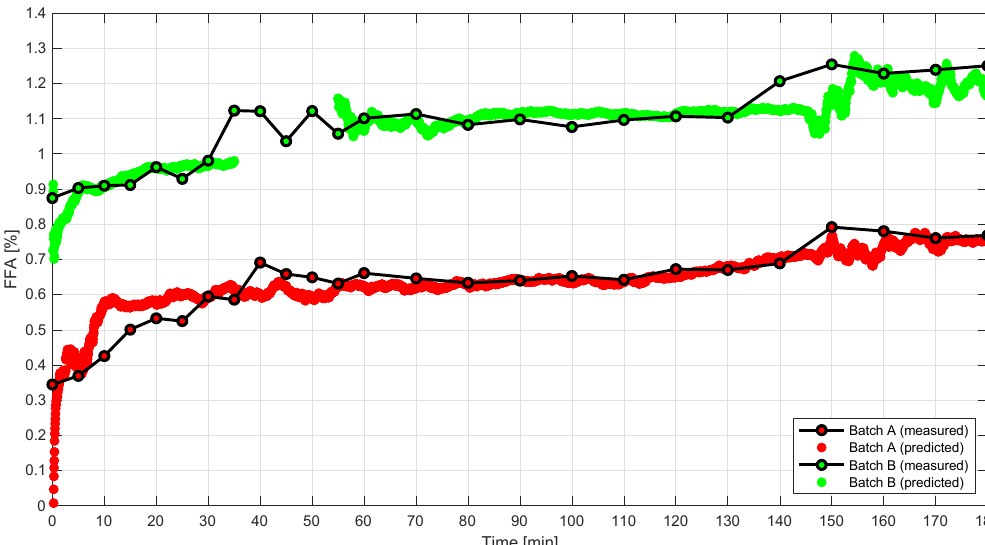
Figure 9. Predicted FFA content using the optimal calibration model (rPLS model with eight variables included and five LVs) on data averaged with a window width of 150 s. The predictions of batch A and B are colored in red and green, respectively. The reference values are plotted as black lines.